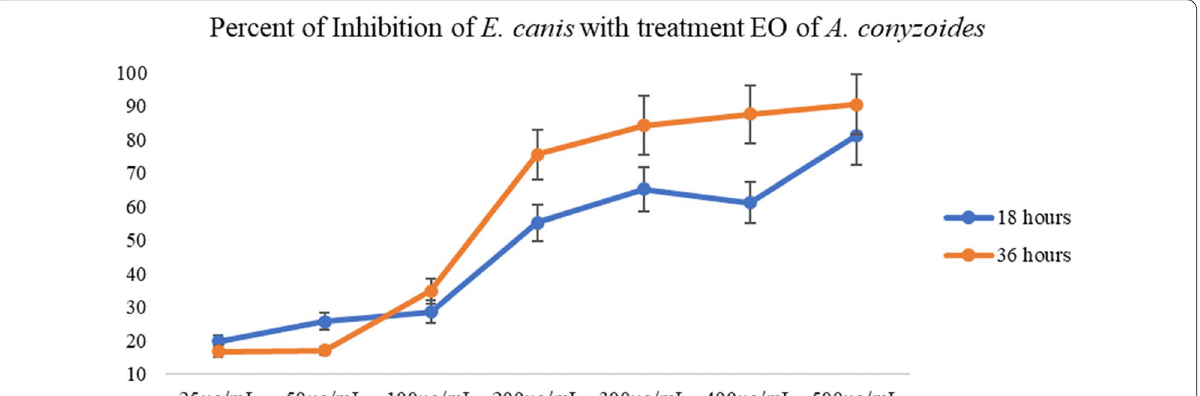
Fig. 1 Percent of inhibition of Ehrlichia canis in DH82 cells, after 18 and 36 h of treatment as essential oil of A. conyzoides , in different concentrations. Each line represents medium and deviant pad of three independent